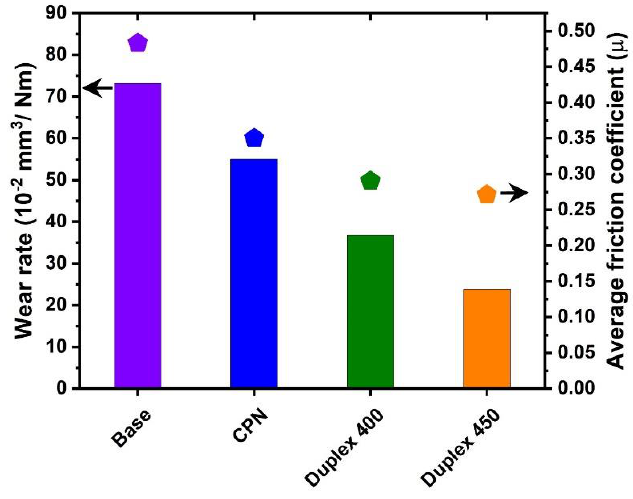
Figure 10. Wear rate and average friction coefficient of base sample and CPN and duplex-treated samples with substrate temperature for TiN deposition at 400 °C and 450 °C.